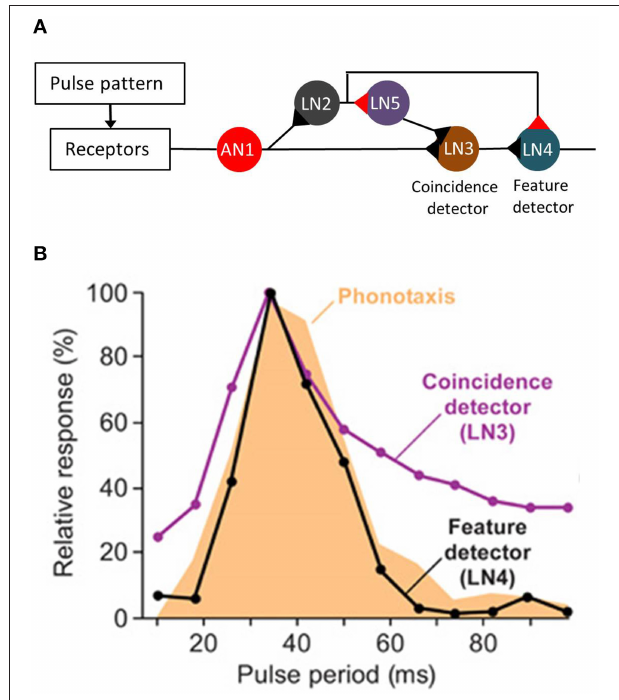
FIGURE 1 | Pulse pattern recognition in G. bimaculatus . (A) Schematic drawing of the feature detector involved in the recognition of pulse rates. Black triangles represent the excitatory synapses and red triangles, the inhibitory synapses. LN2 and LN5 caused a delay of the nervous response in LN3 relative to the excitation mediated via AN1. (B) The pulse period tuning of the feature detector LN4 matched female preference. Modified from Schöneich et al.